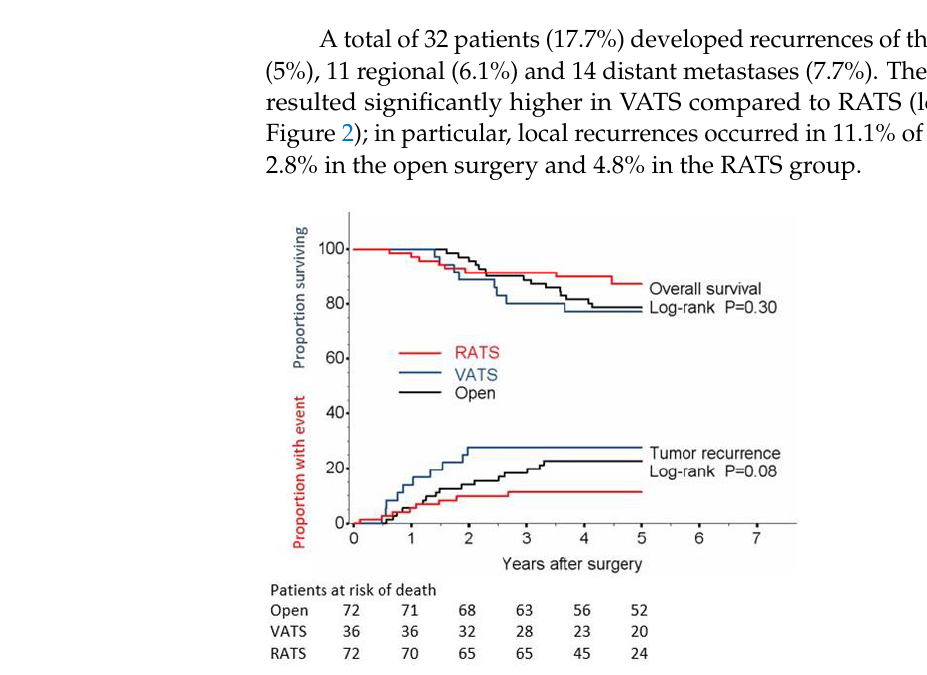
Figure 3. Lung Cancer-Specific survival.